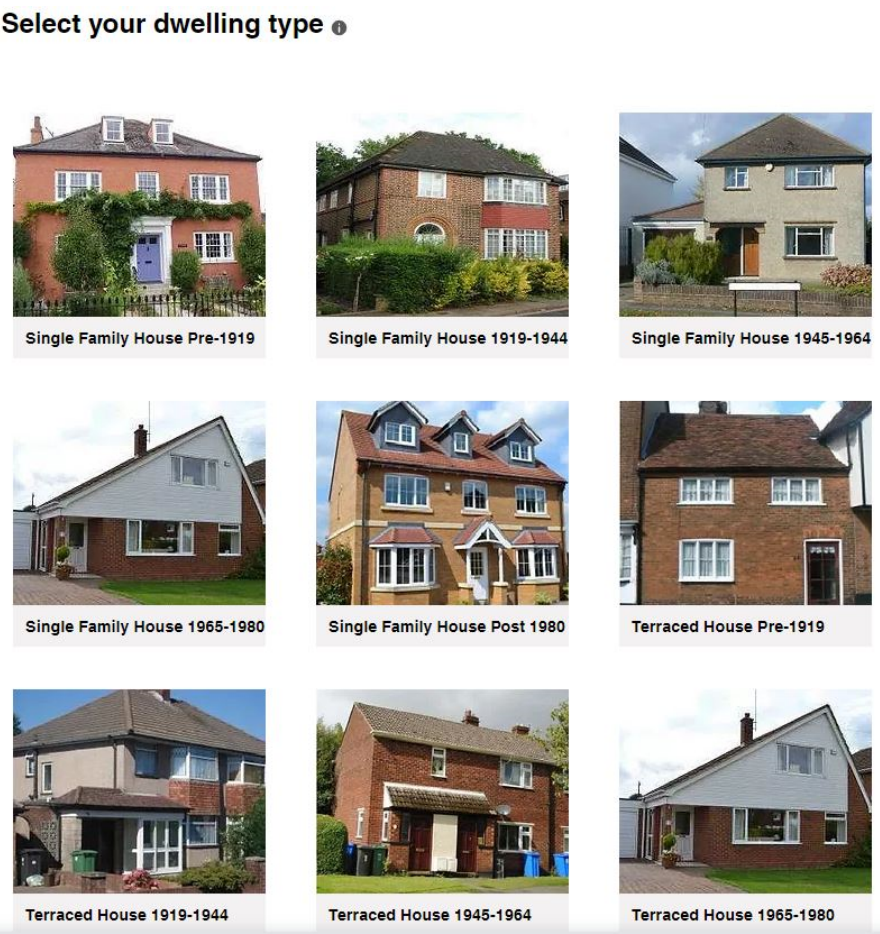
Figure 5. Select your dwelling type